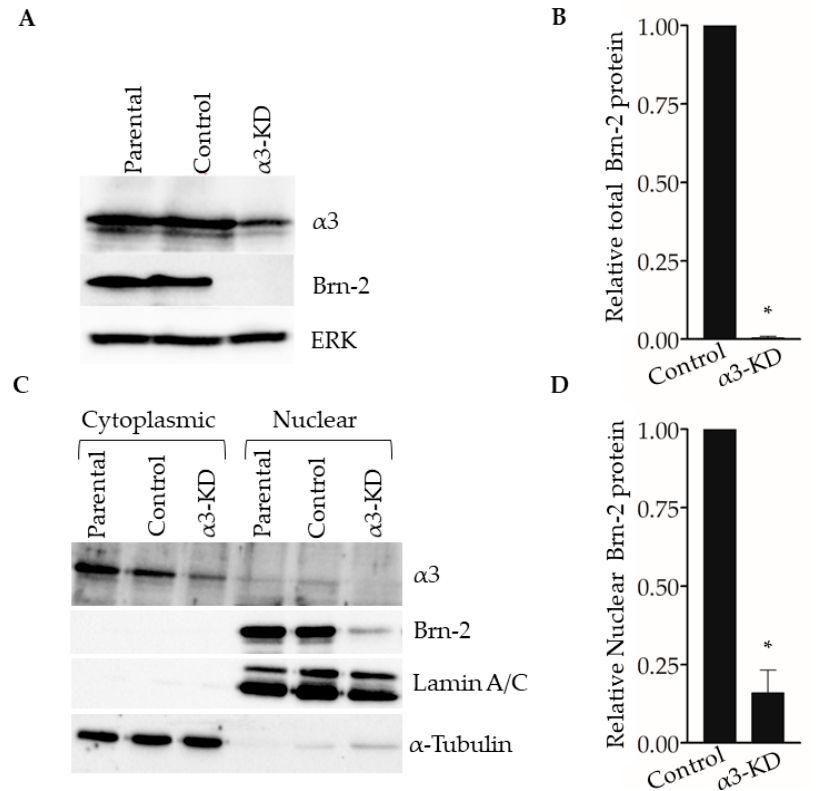
Figure 3. Suppression of integrin α 3 β 1 in MDA-MB-231 cells decreases Brn-2 protein levels. ( A ) Representative Western blot showing integrin α 3, Brn-2, and ERK (loading control) protein levels in whole-cell lysates obtained from MDA-MB-231 parental (i.e., non-transduced) cells, or cells expressing either non-targeting (Control) or α 3-targeting ( α 3-KD) shRNA. ( B ) Relative Brn-2 protein in α 3-KD cells normalized to control. ( C ) Representative Western blot showing subcellular localization of Brn-2 protein. Cytoplasmic and nuclear fractions were obtained from parental, control, and α 3-KD cells. α -Tubulin and LaminA/C served as fractionation markers. ( D ) Relative nuclear Brn-2 protein in α 3-KD cells normalized to control. n = 3; mean +/ − SEM; * p < 0.05; two-tailed T - test.